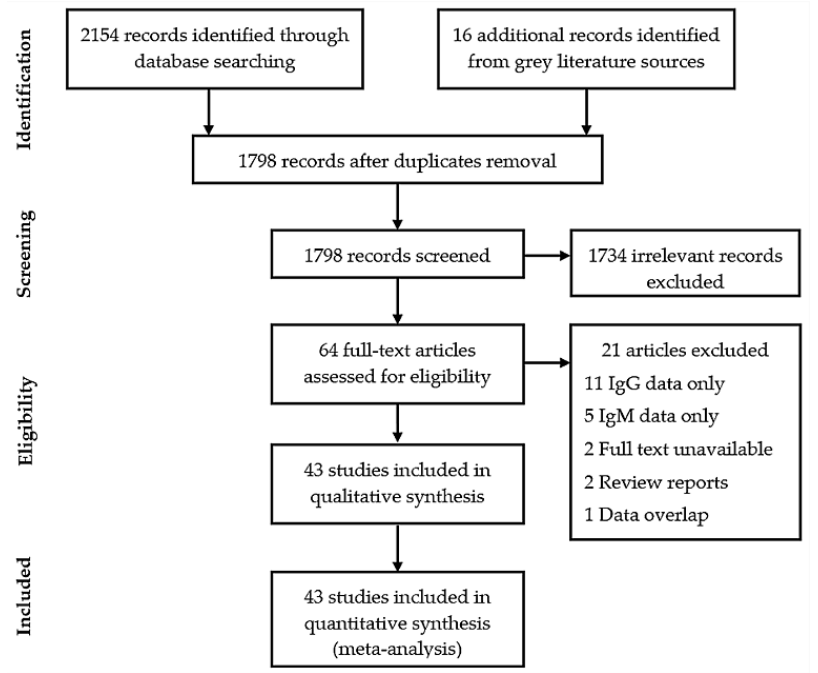
Figure 1. PRISMA flow chart illustrating literature selection and inclusion process.